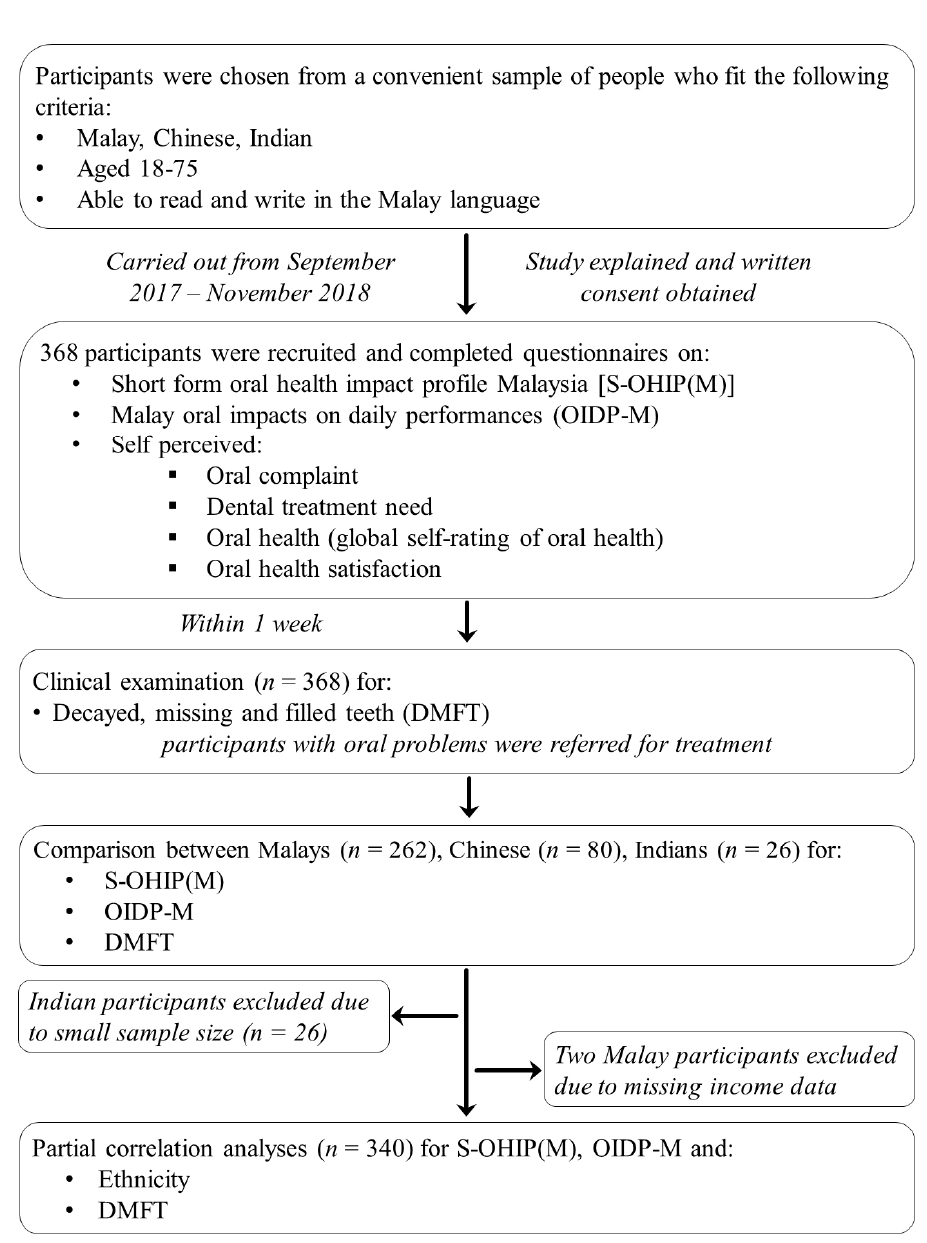
Figure 1. Participant recruitment, assessment, and inclusion for data analyses.